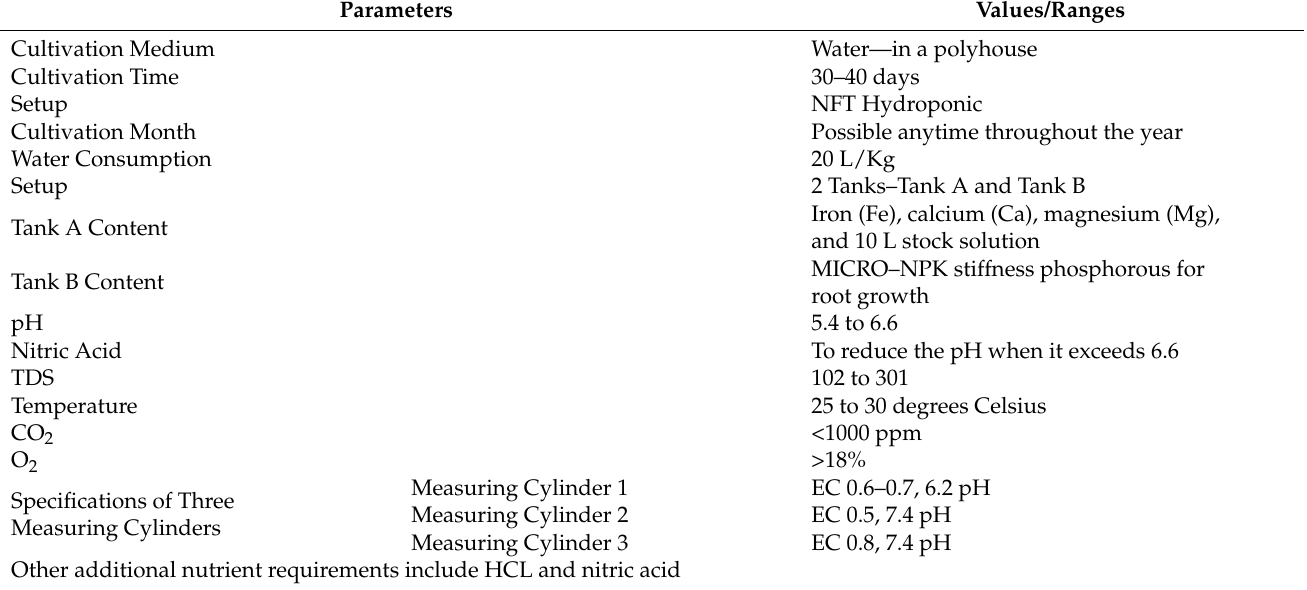
Table 3. Parameters and their corresponding values in the NFT method of hydroponics.